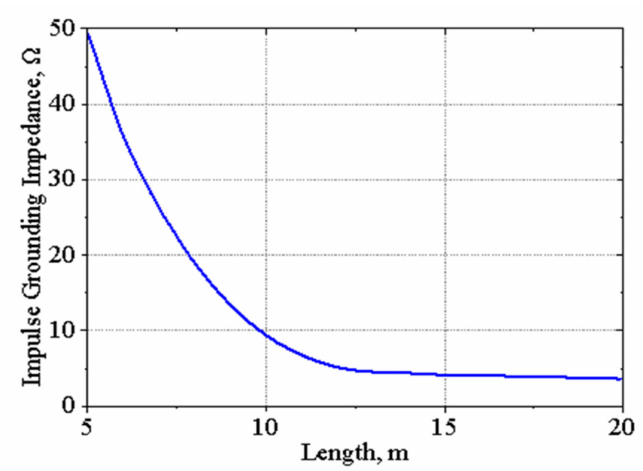
Figure 10. Influence of the length on the impulse grounding impedance of a 1 × 1 mesh with soil resistivity of 500 Ω m, critical electric field of 10 kV/cm, current peak of 100 kA and 1/200 µ s